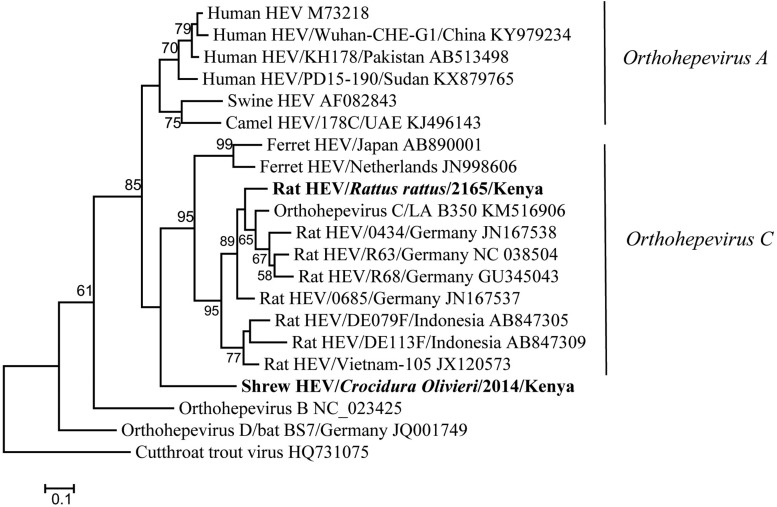
ML tree based on 254-nt partial RdRp gene of hepeviruses (corresponding to Orthohepevirus C strain LA-B350 genome nt 4145-4398, KM516906). Strains detected in this study are indicated in bold.